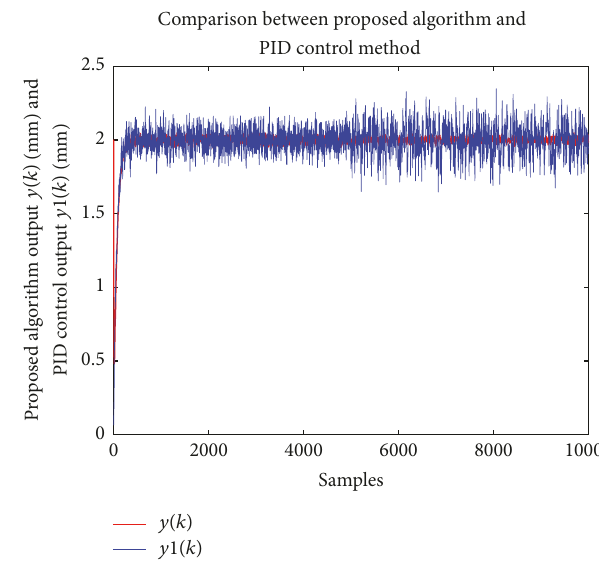
Figure 12: Comparison between proposed algorithm (red) and PID control (blue).